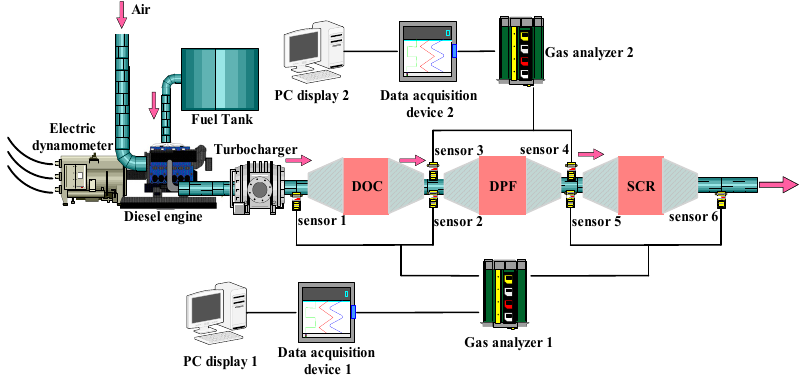
Figure 2. Schematic diagram of the experimental device.